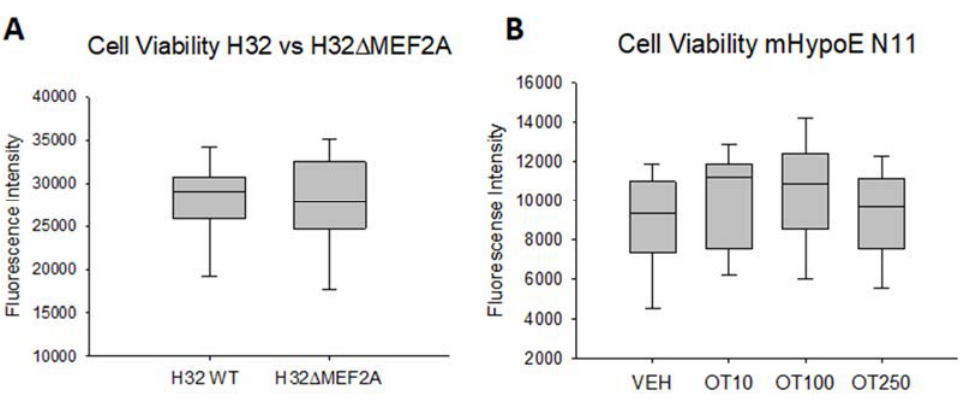
Figure A1. Mitochondrial function in H32 wild ‐ type and H32 Δ MEF2A cells. n = 3 per group.